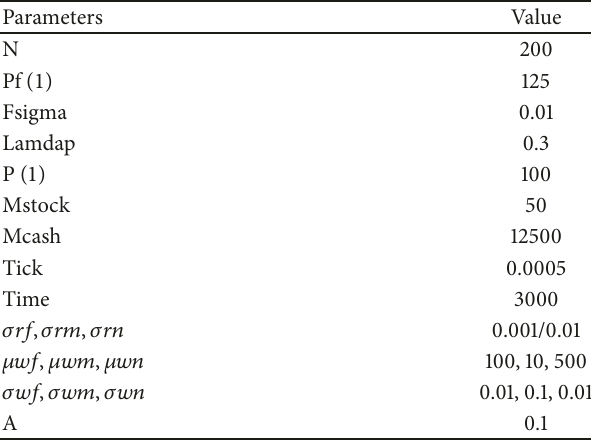
Table 4: Values of the